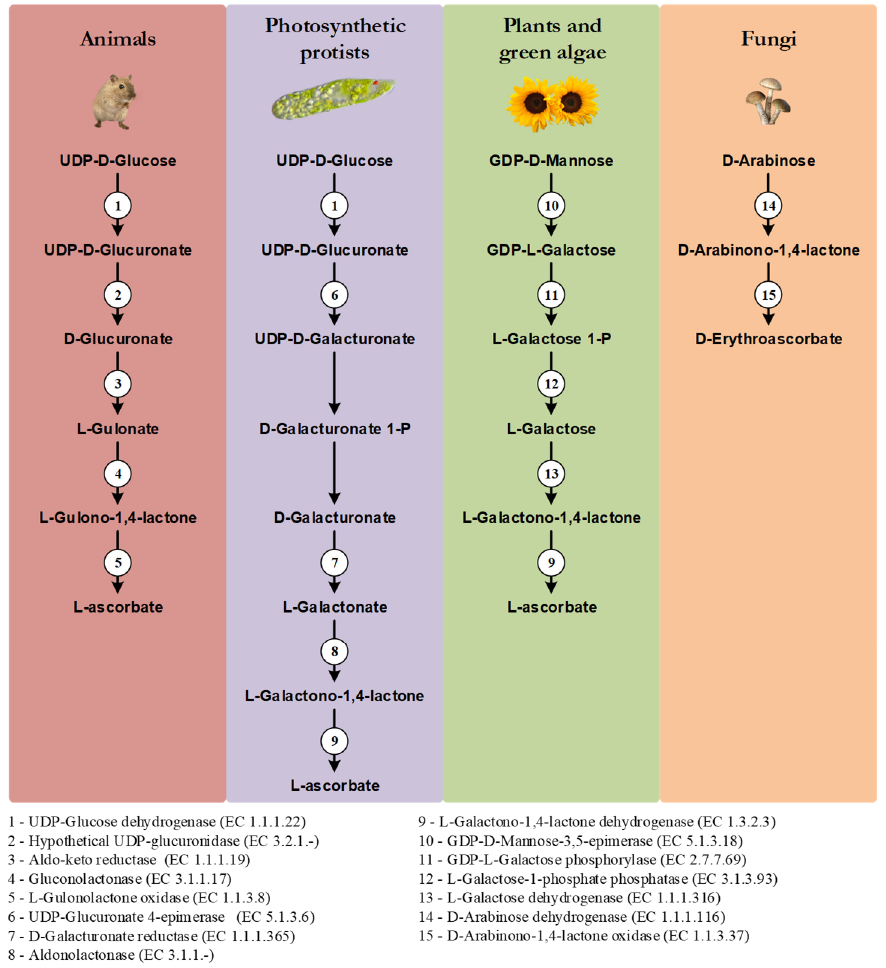
Figure 1. Graphical illustration of the main VC and D-erythroascorbate synthesis pathways, adapted from the MetaCyc database [108] . The numbered circles represent enzymes that are known to catalyze the substrate conversions within the pathways (see the enzyme list presented below the illustration). Reaction steps without an attributed enzyme are performed by unknown enzymes.